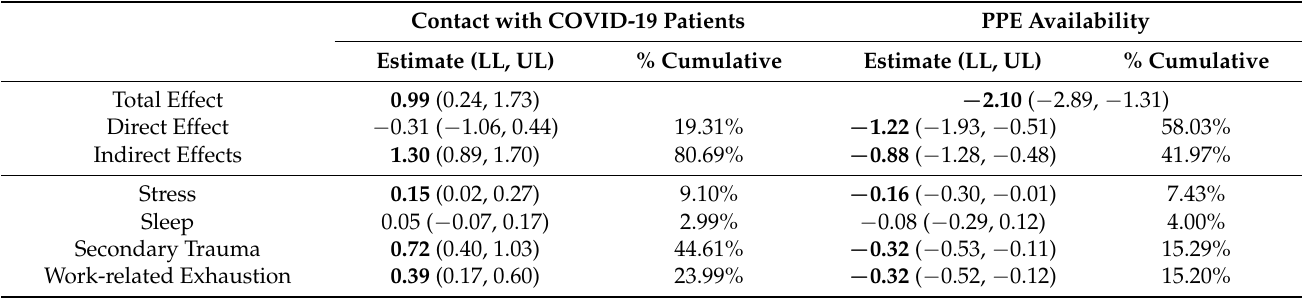
Table 5. Path model testing the hypothesis of parallel, multiple mediation of Contact with COVID-19 patients and PPE Availability on Workplace Cognitive